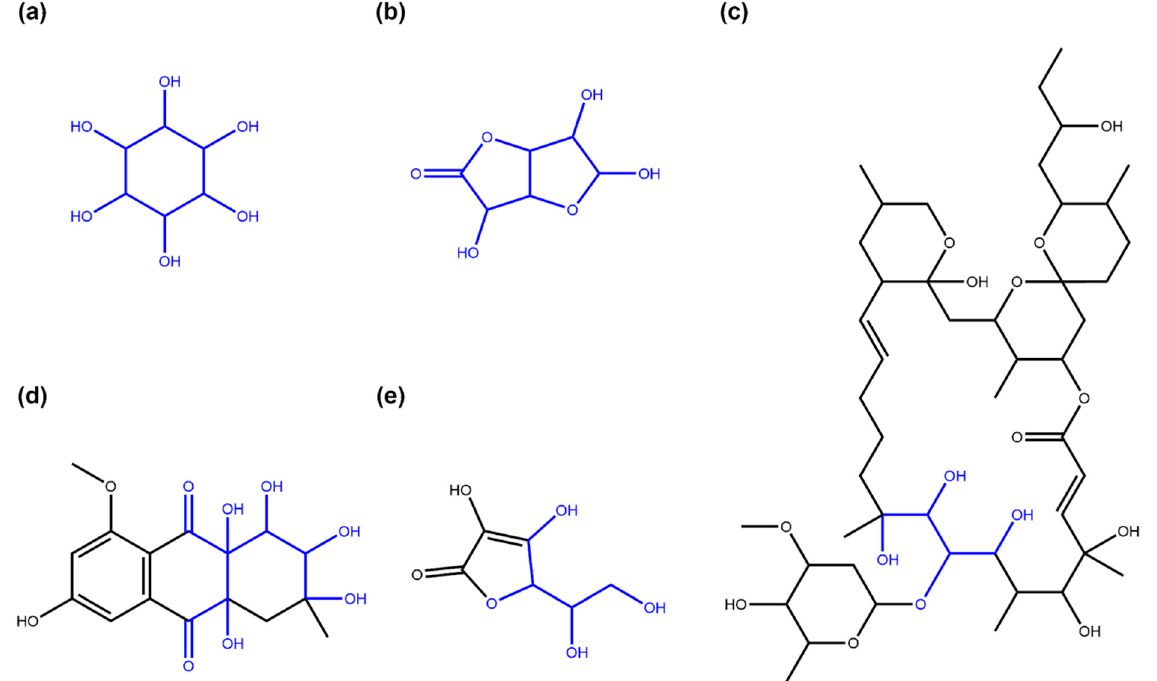
Figure 9. Examples of NP structures the SRU detects as linear sugars inside ring systems. ( a ) Inositol (COCONUT ID CNP0254016), a sugar-like cycle without ring oxygen (pseudo sugar) that is detected by the SRU linear sugar detection as a whole if the detection of linear sugars in rings is turned on. ( b ) 3,5,6-trihydroxy-hexahydrofuro[3,2-b]furan-2-one (CNP0261065), a structure that resembles two fused furanose rings and is detected as a whole by the linear sugar detection algorithm of the SRU if the option to allow detection of cyclic linear sugars is set. ( c ) Cytovaricin (CNP0392685), a macrolide that contains a linear sugar detectable by the SRU (in blue). ( d ) Chrysolandol (CNP0278335), a ring system with many hydroxy and keto groups that can be detected as a cyclic linear sugar (in blue). ( e ) Vitamin C (CNP0367758), a furanose-like structure that is undetectable for the circular sugar detection algorithm of the SRU because of its cyclic double-bond but can partwise be detected in linear sugar detection as a cyclic linear glycoside (detected structure in blue).